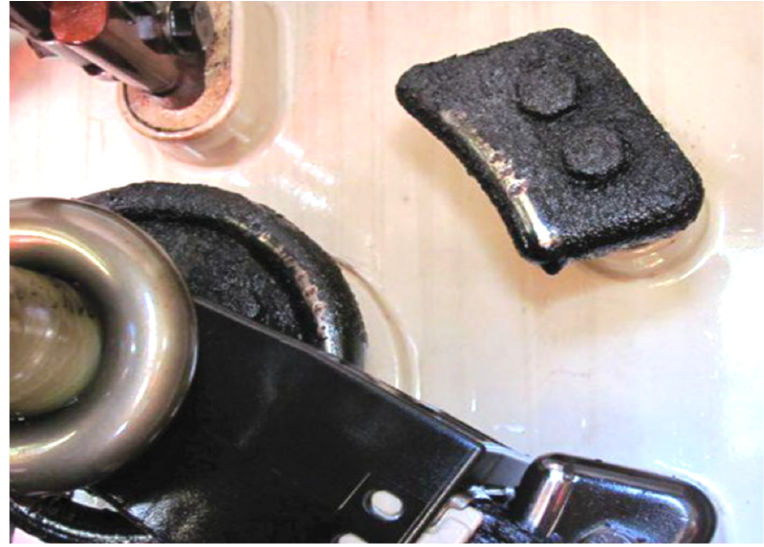
Figure 7. Coked reversal contact [15].